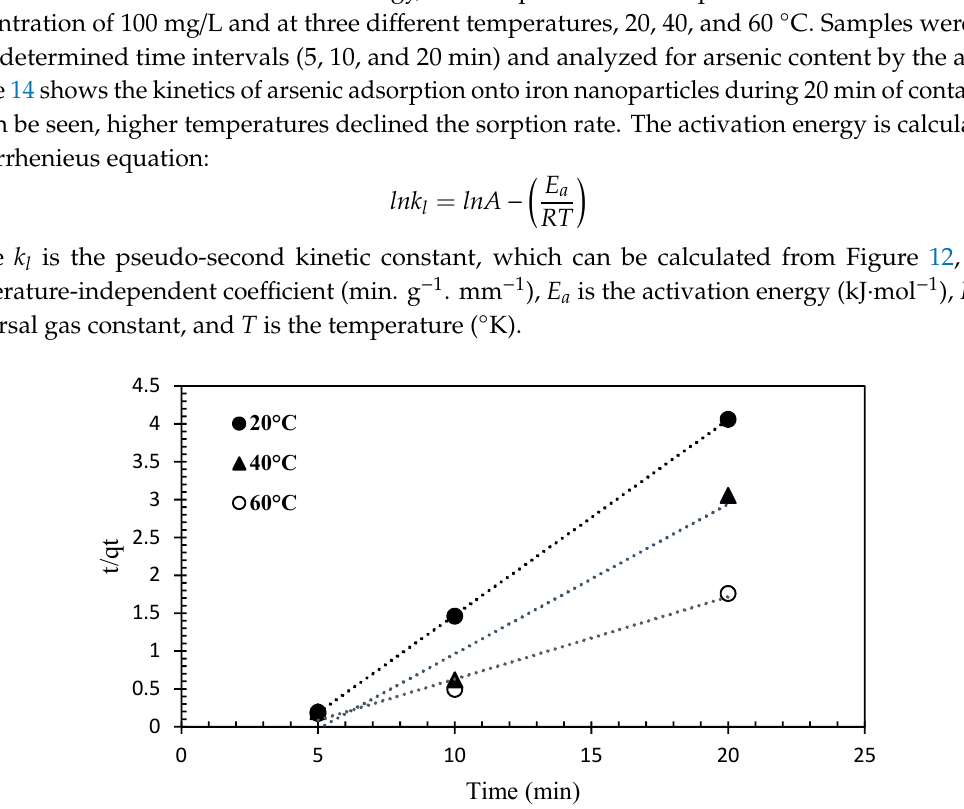
Figure 15. The lnk 1 variations versus 1000/T. 3.7. Arsenic R emoval from Real Mining Effluents Real arsenic-containing effluent samples were collected from Meiduk (Kerman province, Iran) and Ghale Zari (South Khorasan province, Iran) copper processing plants and analyzed for their